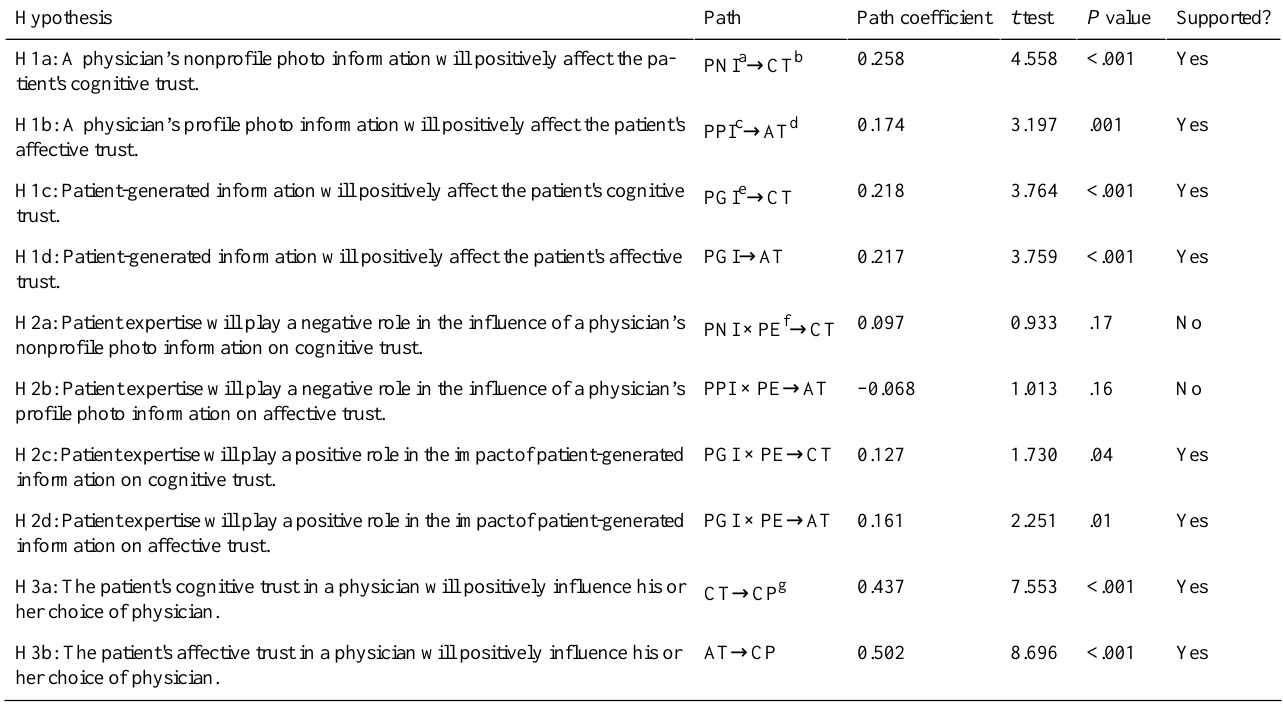
Table 6. Results of hypothesis testing.